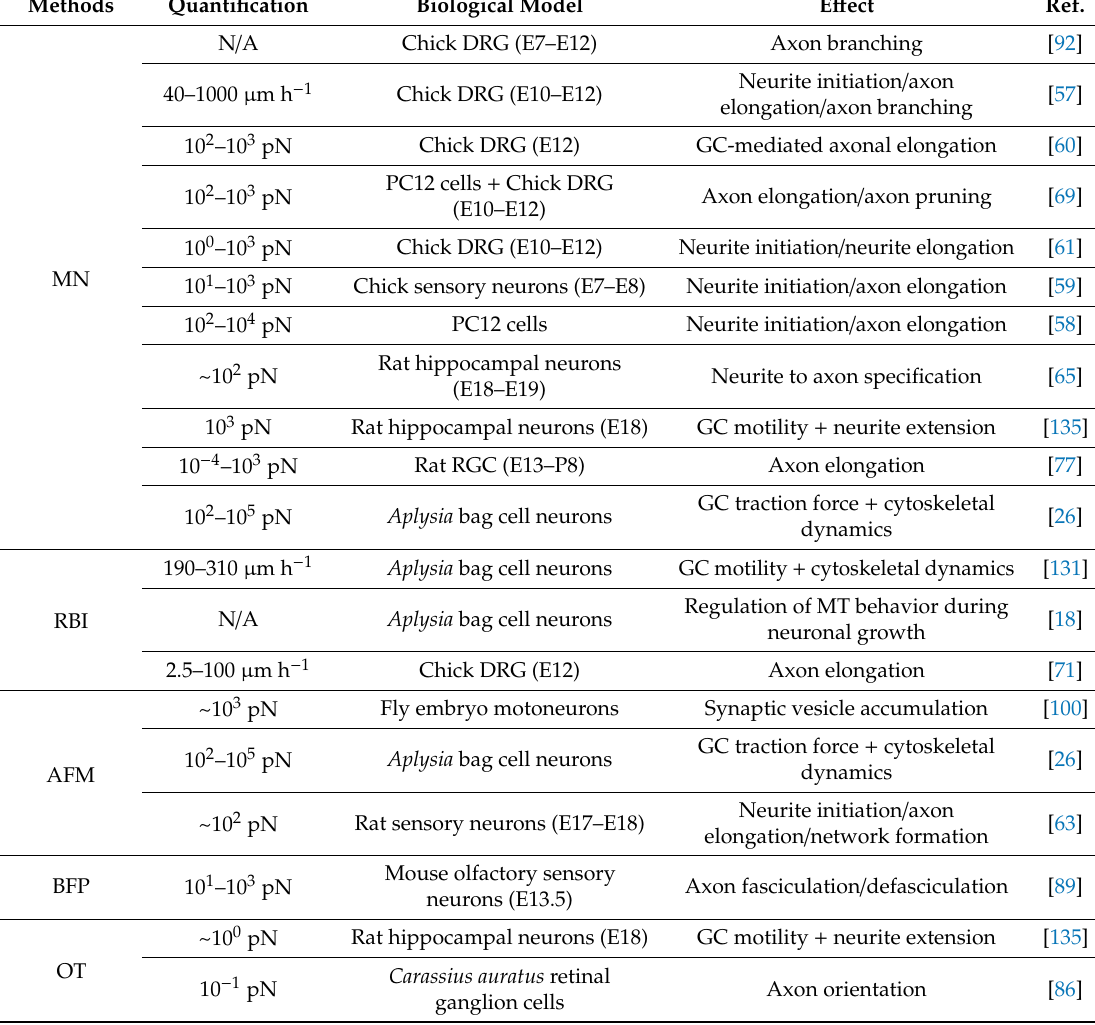
Table 1. Main methods for the application of exogenous forces. MN (force-calibrated microneedles), RBI (restrained-bead interaction), AFM (atomic force microscopy), BFP (biomembrane force probe), OT (optical trap), MTW (magnetic tweezers), MNP (magnetic nanoparticles), TFM (traction force microscopy), MEM (micromechanical system), SCG (superior cervical ganglion), P (post-natal),